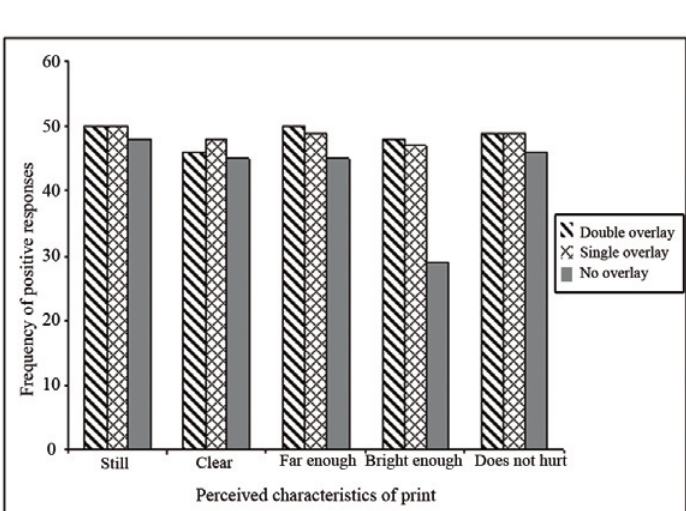
Figure 1. Showing the frequency of the responses to each ques- tion through the best double overlays (Aqua/blue), best single overlay (blue) and no overlay. Both best overlays yielded great- er positive responses for all the five questions than without an